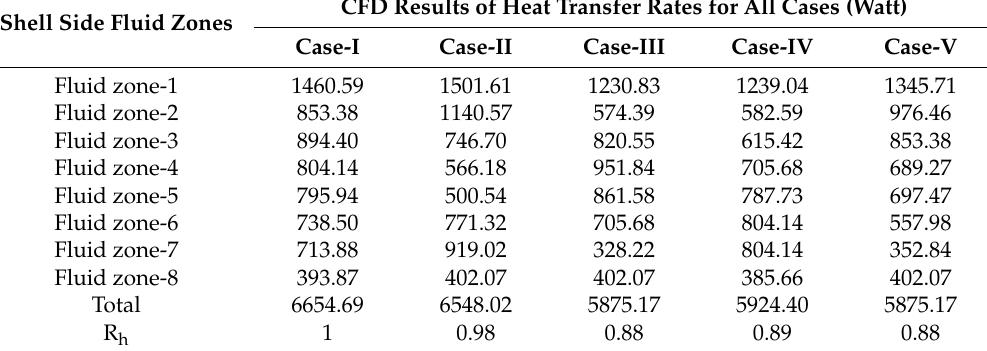
Table 6. Predicted heat transfer rates on the shell side for all